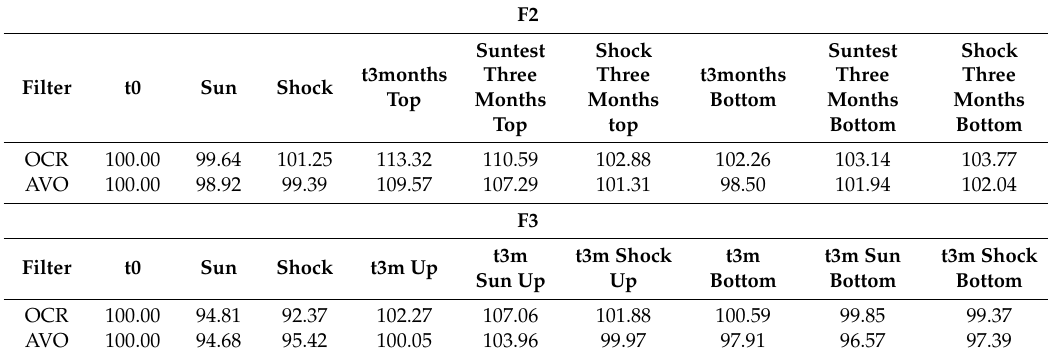
Table 10. Filters in formulations with relation to untreated formulations